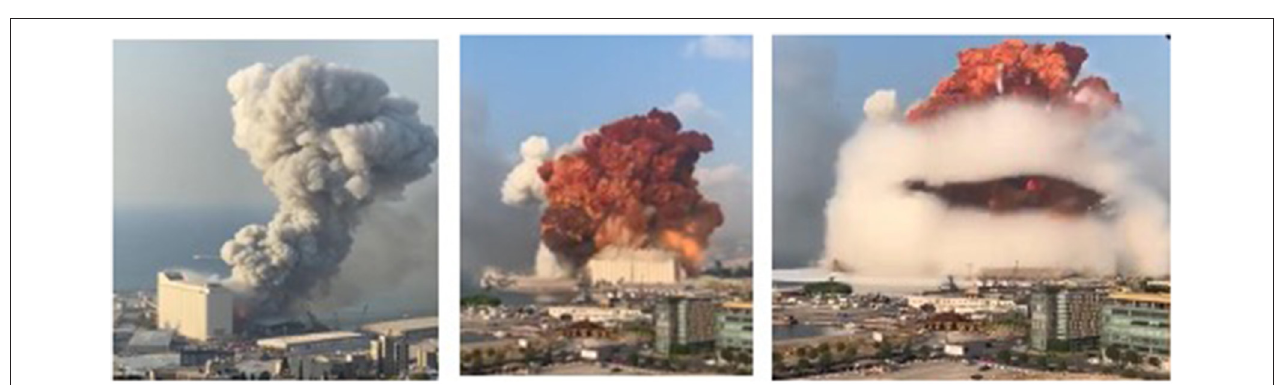
FIGURE 2 | Blast explosion at time 5:55 pm (initial explosion) and at 6:08 pm (orange and mushroom cloud) at the port of Beirut (Source online).